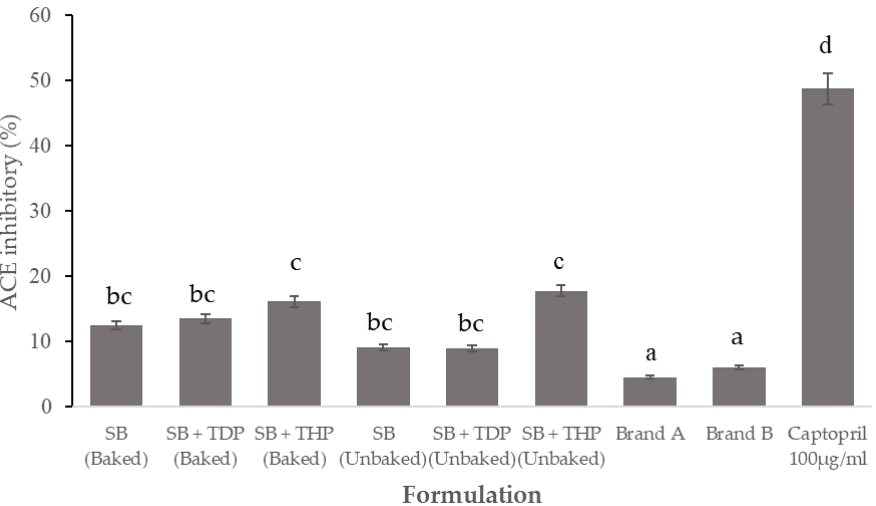
Figure 4. ACE inhibitory activity of snack bar products. Values that contain different letters are significantly different at p < 0.05.